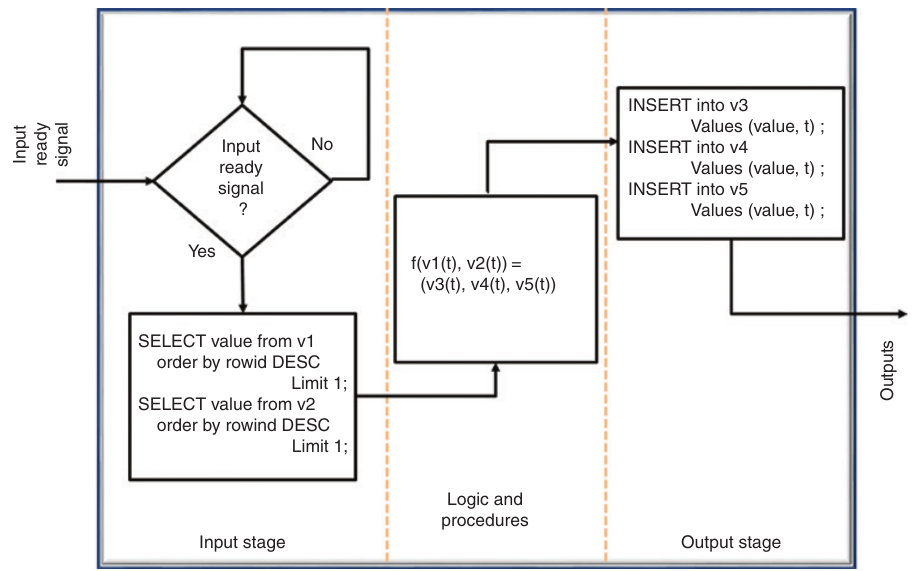
Figure 7: Device Network Over Distributed